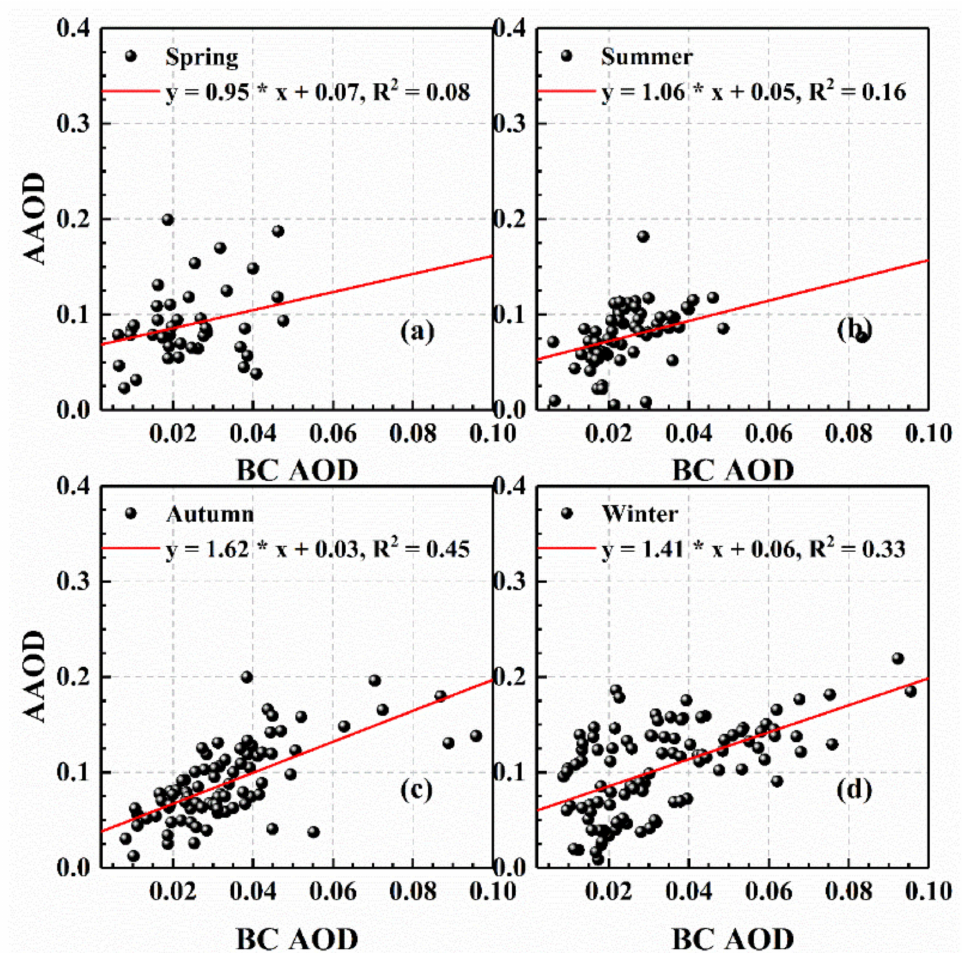
Figure 5. Dependence of AAOD on BC AOD in ( a ) spring; ( b ) summer; ( c ) autumn; ( d ) winter over Wuhan, China from 2013 to 2016. The red lines in the plots are the linear